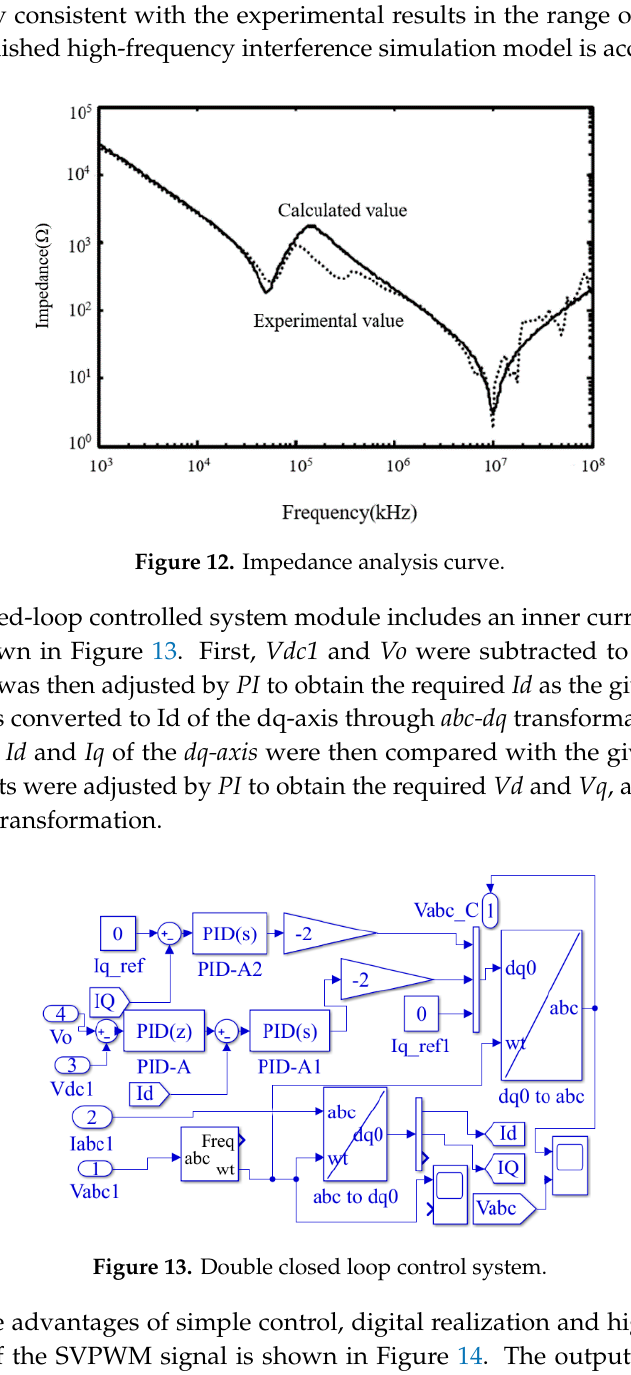
Figure 13. Double closed loop control system.